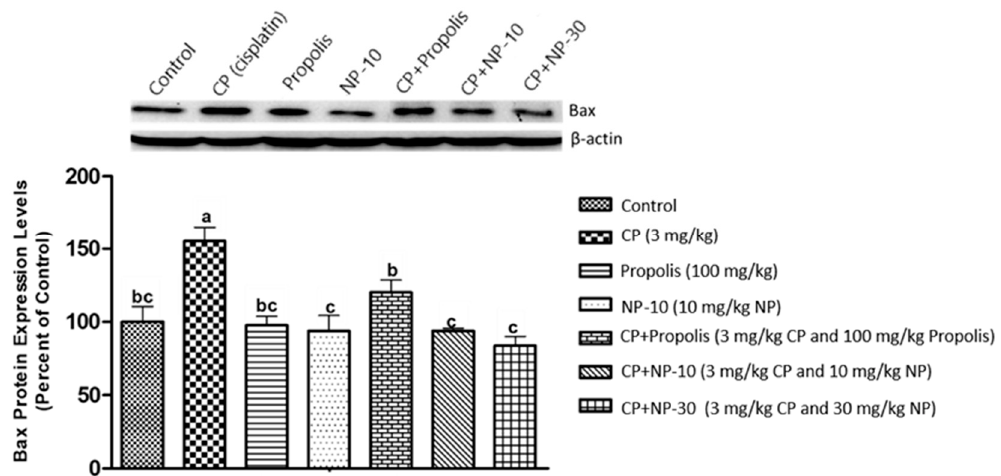
Figure 1. Bax protein expression levels in liver tissue. a,b,c: Mean values within a row differ significantly, Significance is p < 0.001 (NP: nano-propolis).